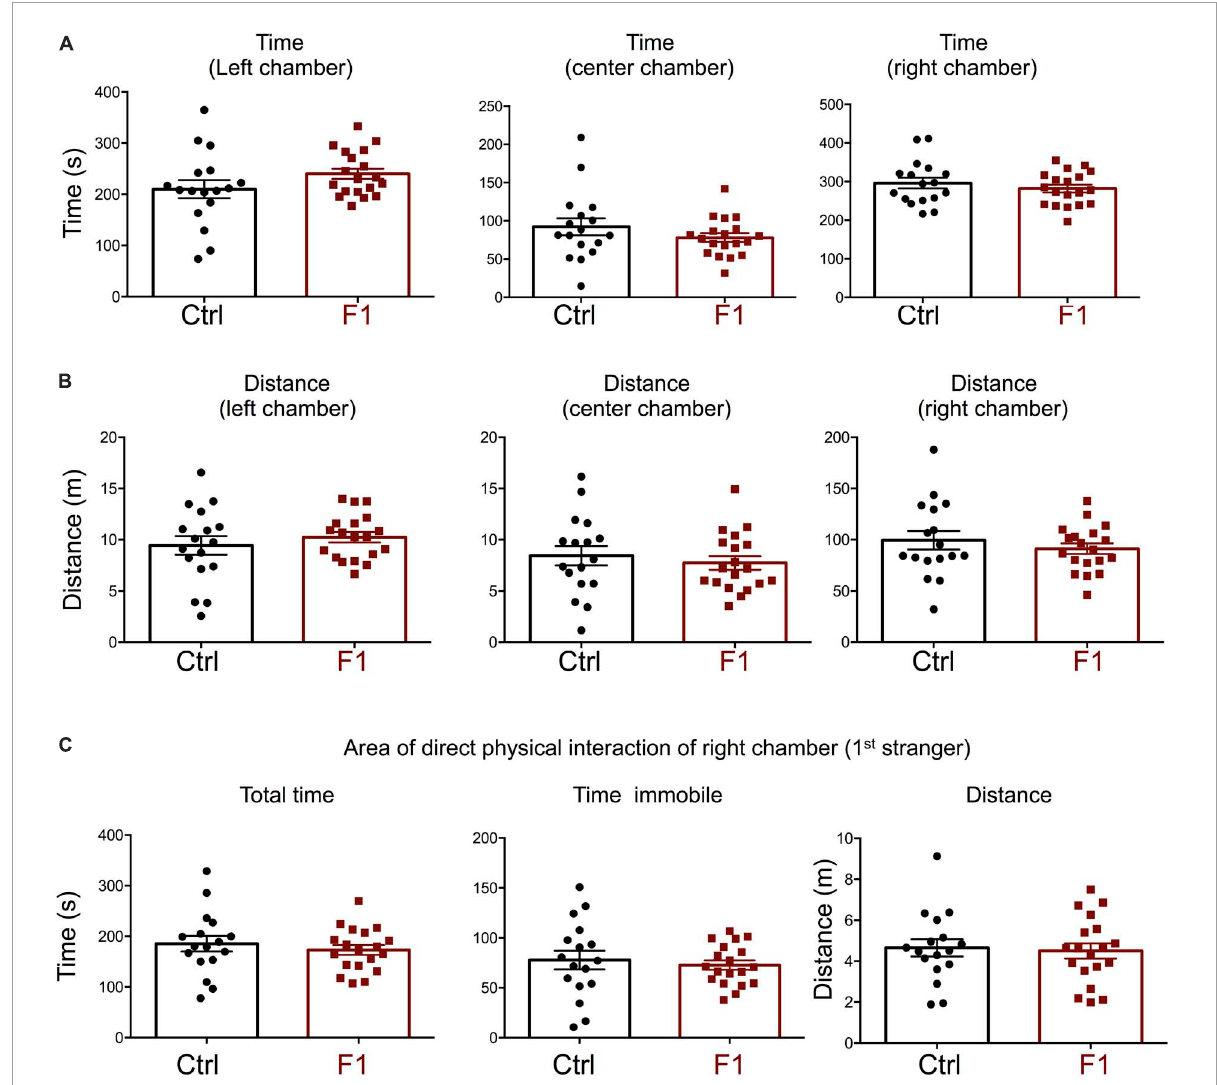
FIGURE7 Sociability of F1 generation females. (A–C) Second trial of the three-chamber social box test, after first stranger is introduced in the right chamber. (A) Time spent by the test mouse in each chamber. (B) Distance traveled by the test mouse in each chamber. (C) Total time, time immobile, and distance traveled by the test mouse in the area immediately around the 1st stranger in the right chamber. Each point represents a different mouse tested at approximately 18 weeks of age ( n = 17, 19) and mean ± SEM are shown. Experimental mice from each group represent 4–6 different litters and data represent two animal cohorts that were generated and tested at different